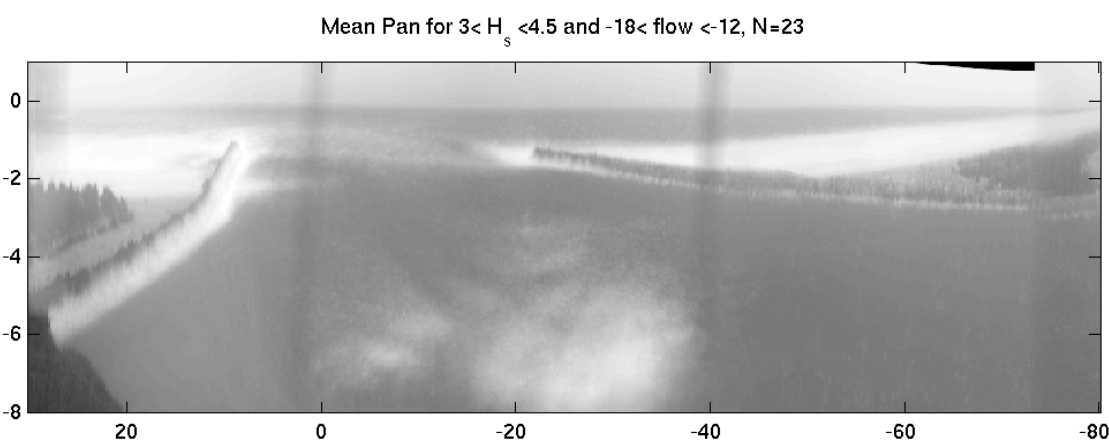
Figure 14. Bin-averaged “brightest” pan for wave heights between 3.0 and 4.5 m and spring ebb flows. The enhanced breaking over Guano Rock continues but the breaking at the mouth of the inlet is more evident.